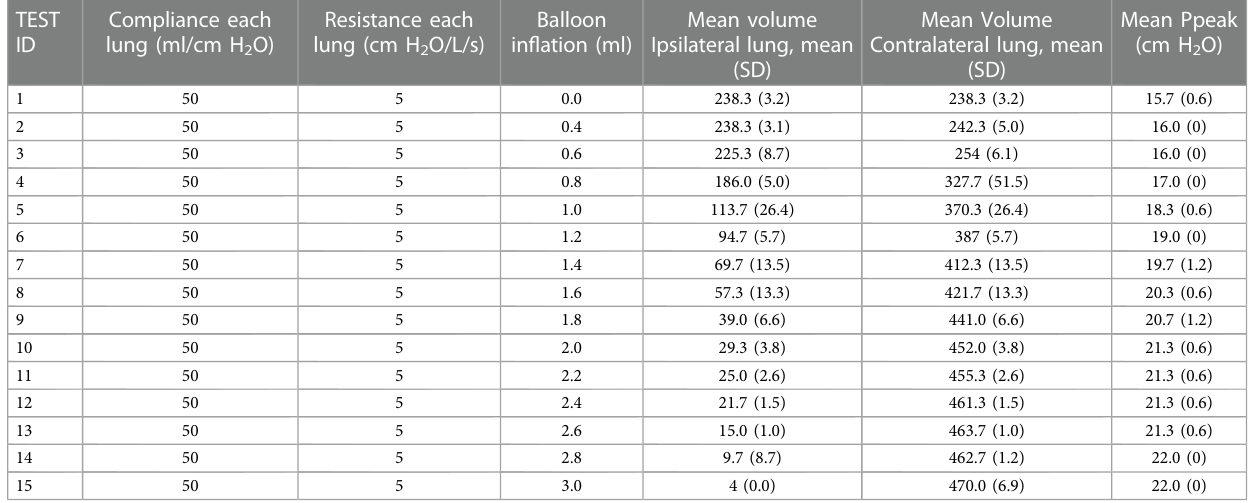
TABLE 1 SAFR-guided redistribution of the